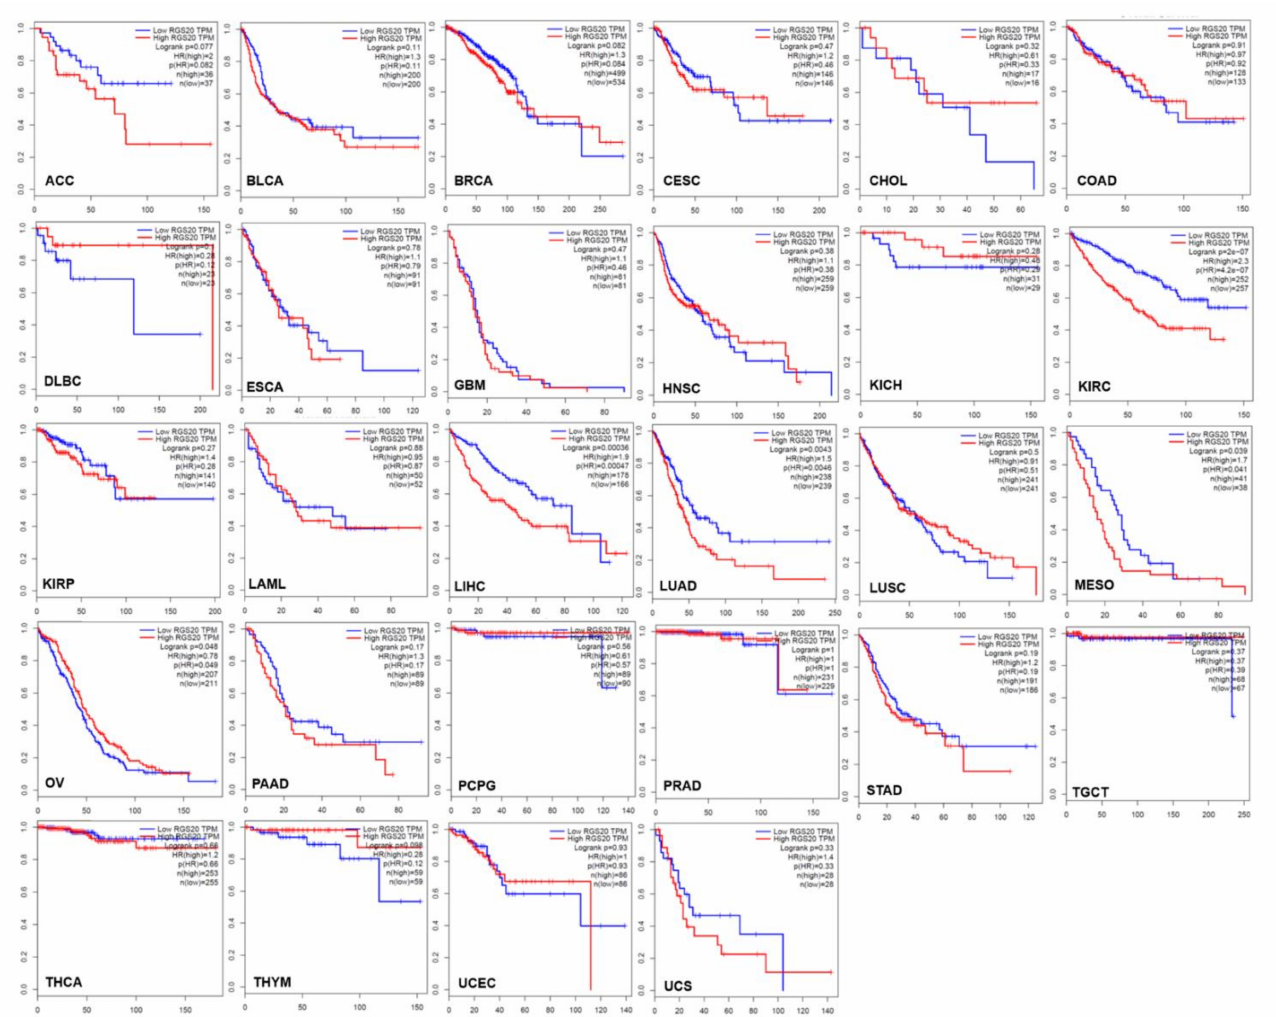
Figure 2. RGS20 survival probability in 28 cancers. KM curves show data from 28 cancers. Pa- tients were classified into low and high expression groups based on the median value of RGS20 in each